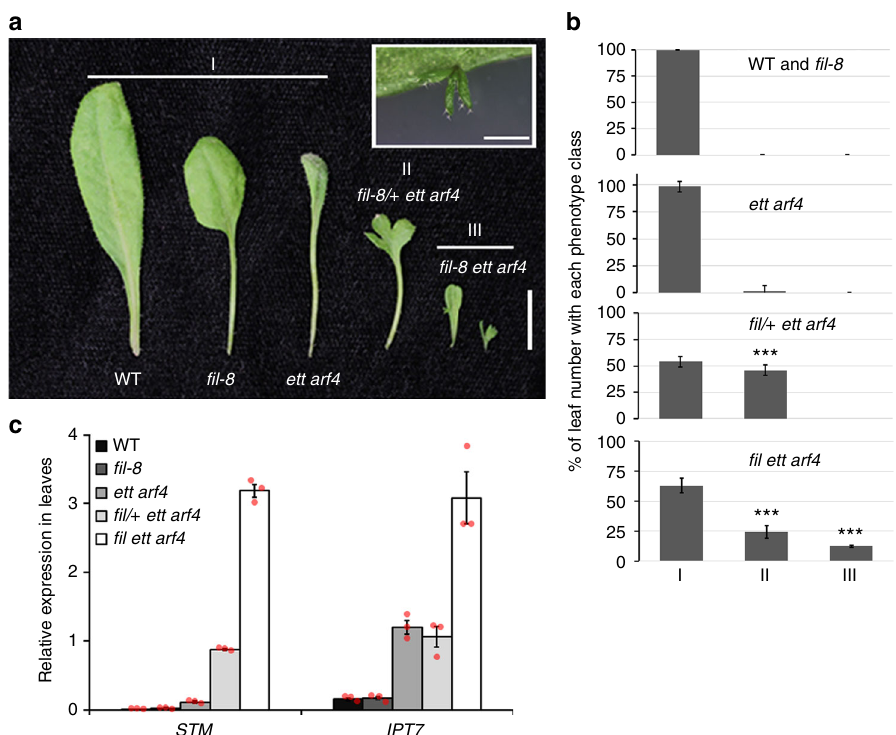
Fig. 6 Leaf phenotypes of plants with reduced FIL, ETT and ARF4 activity. a Representative images of leaf phenotypes of wild type (WT), fi l-8 , ett arf4 , fi l/ + ett arf4 and fi l-8 ett arf4 . I-III indicate the different phenotypic classes observed. I simple leaves; II lobed leaves; III divided leaves and leaves bearing